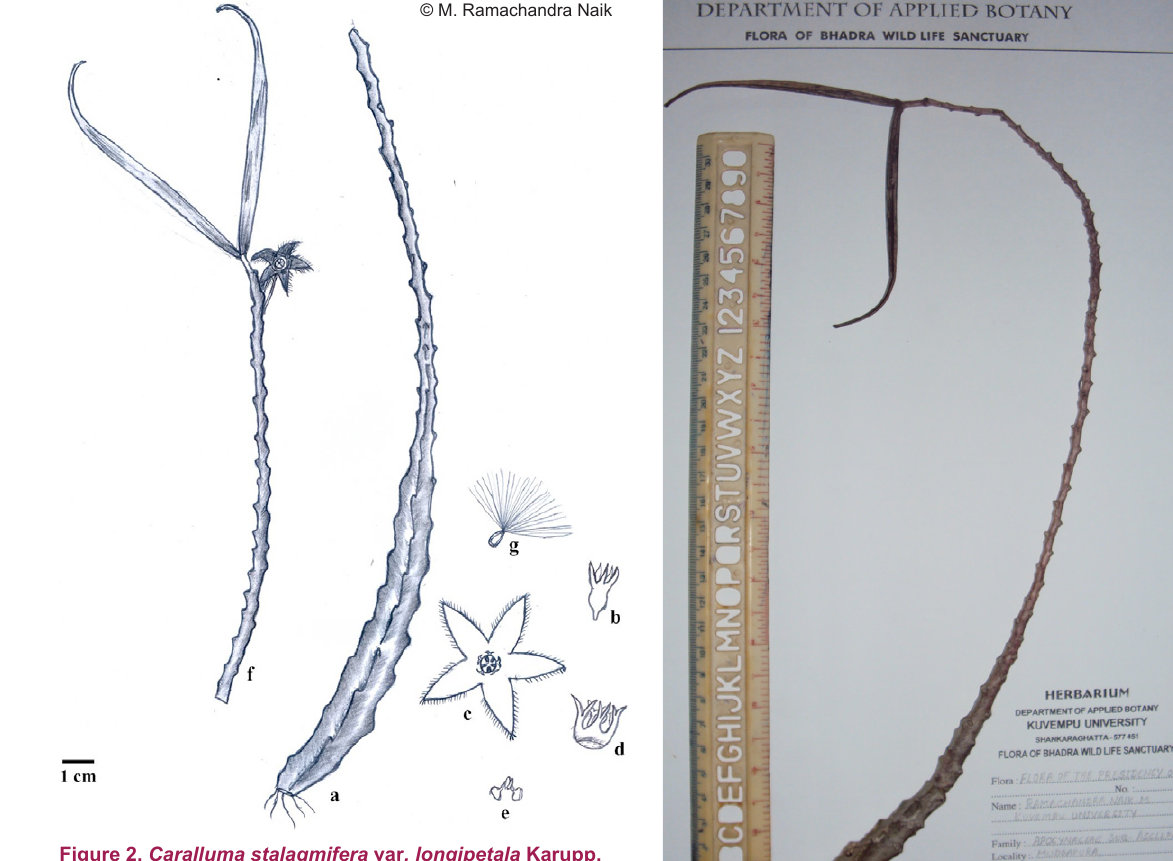
Figure 2. Caralluma stalagmifera var . longipetala Karupp. & Pull. a - habitat; b - calyx; c - corolla; d - corona; e - pollinia; f - fruiting twig; g - seed